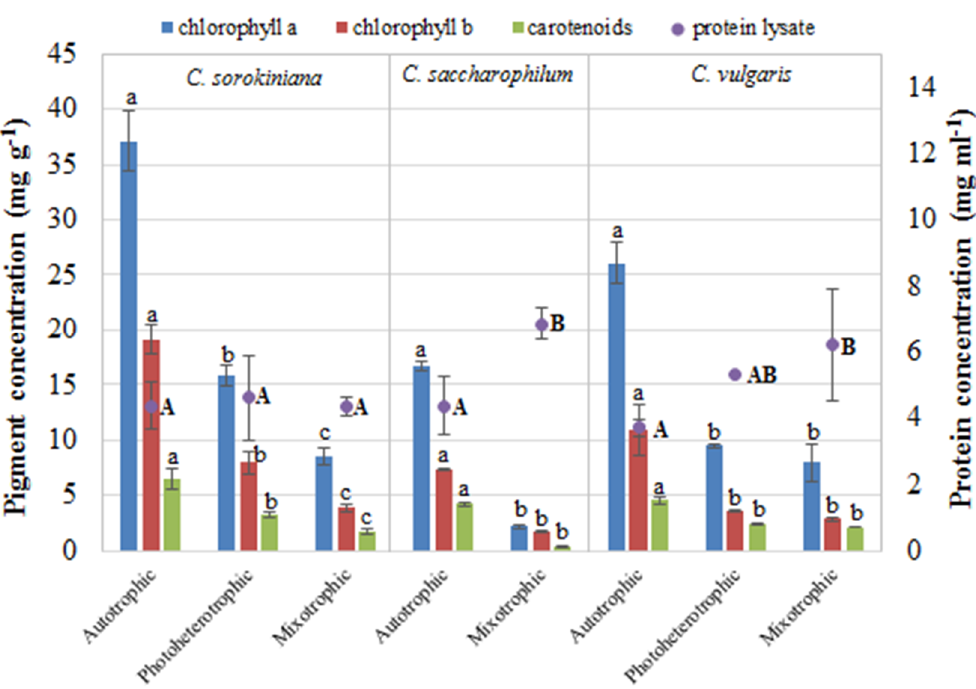
Figure 3. Influence of trophic modes on chlorophyll a (blue columns), chlorophyll b (red columns), carotenoids (green columns), and protein concentrations (purple dots) in C. sorokiniana , C. sac- charophilum , and C. vulgaris (the results are presented as a mean of measurements ± SD; the same letter means no significant differences; Tukey’s honestly significant difference test at p < 0.05).